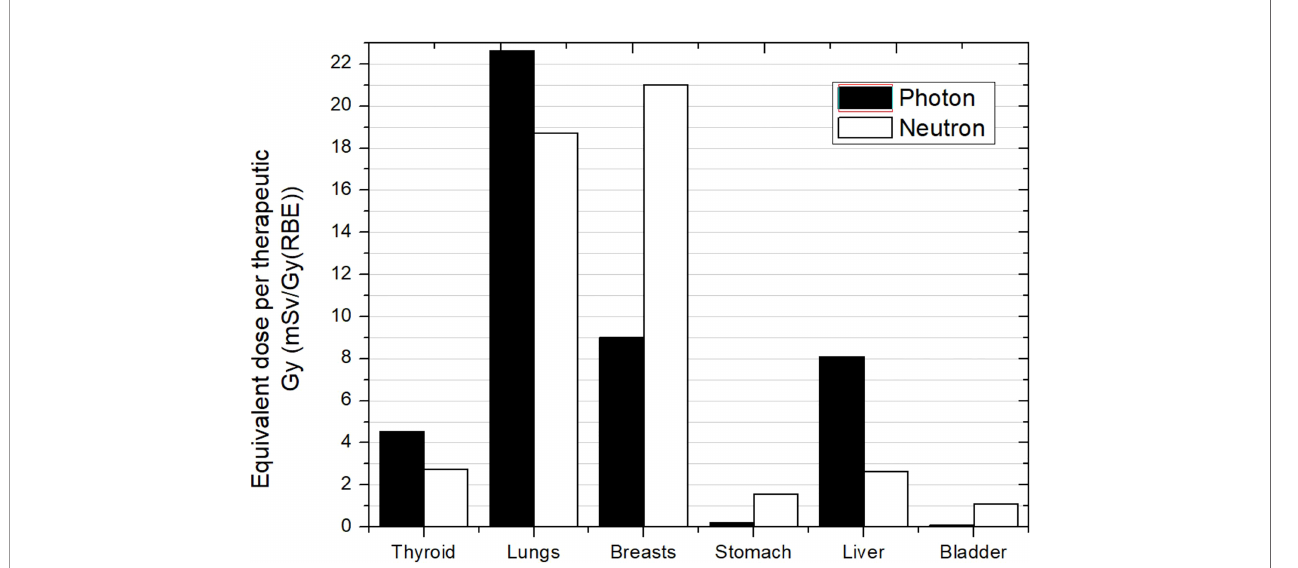
FIGURE 8 | Photon and neutron equivalent doses per therapeutic Gy in selected organs for CSI in a proton pencil beam scanning facility for a 10-year-old anthropomorphic phantom. All fi elds included a range shifter. Data extracted from Majer et al.